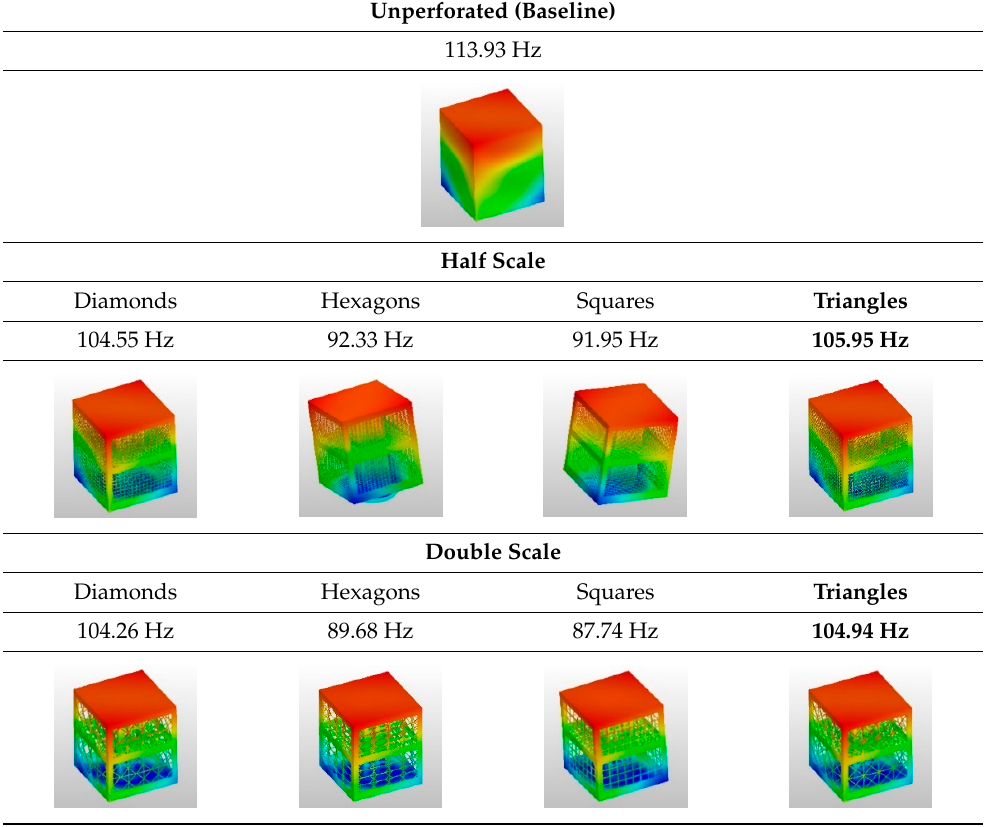
Table 4. Assembled structure fundamental modes.